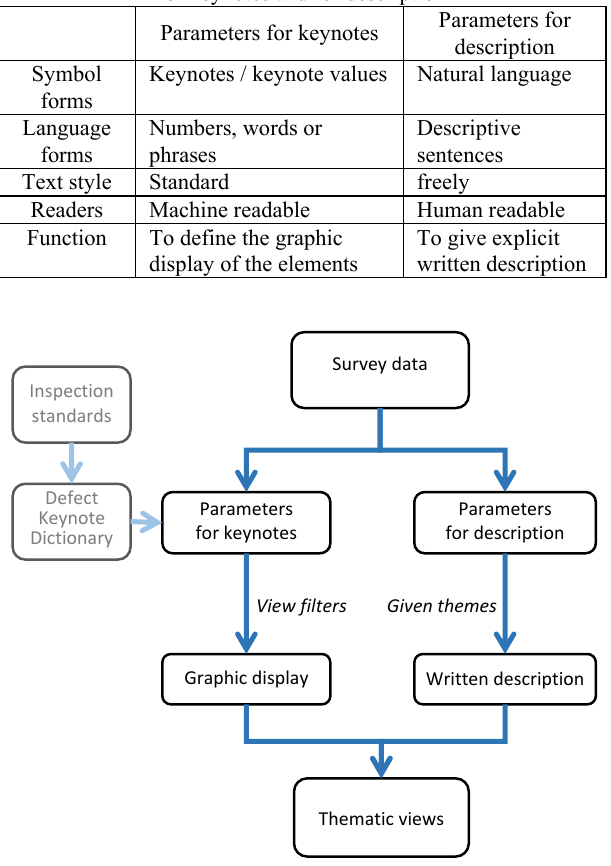
Figure 19 Parameters configuration for thematic